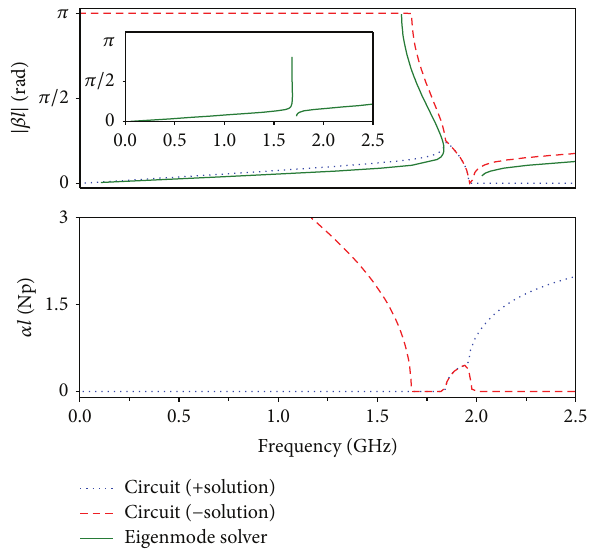
Figure 6: Dispersion relation for the structure of Figure 4 inferred from an eigenmode solver and from its equivalent circuit model of Figure 3(c). The circuit parameters are those indicated in the caption of Figure 5. The dispersion relation for the structure of Figure 4 with 𝑙 = 4.8 mm is depicted in the inset. The attenuation constant 𝛼 is not provided by the eigenmode solver. From [34], reprinted with